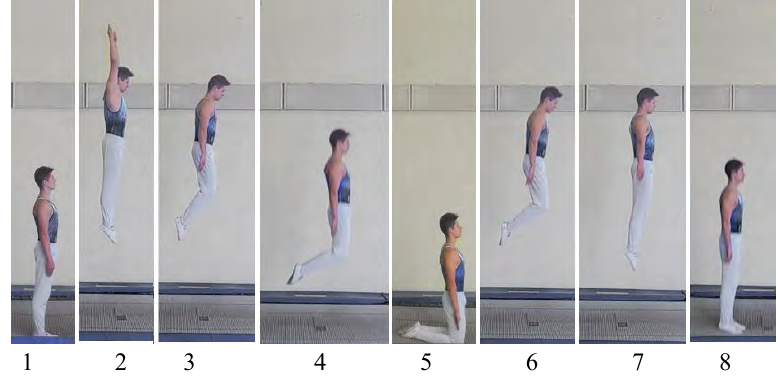
Fig.4. Jump with landing on knees Recommendations: not high temp jumps (vertical position, shots 1-2); jump with landing on knees with straightened toes and arms dropped (shots 3-5); temp jumps with following stop (shots 6-8). Pay attention